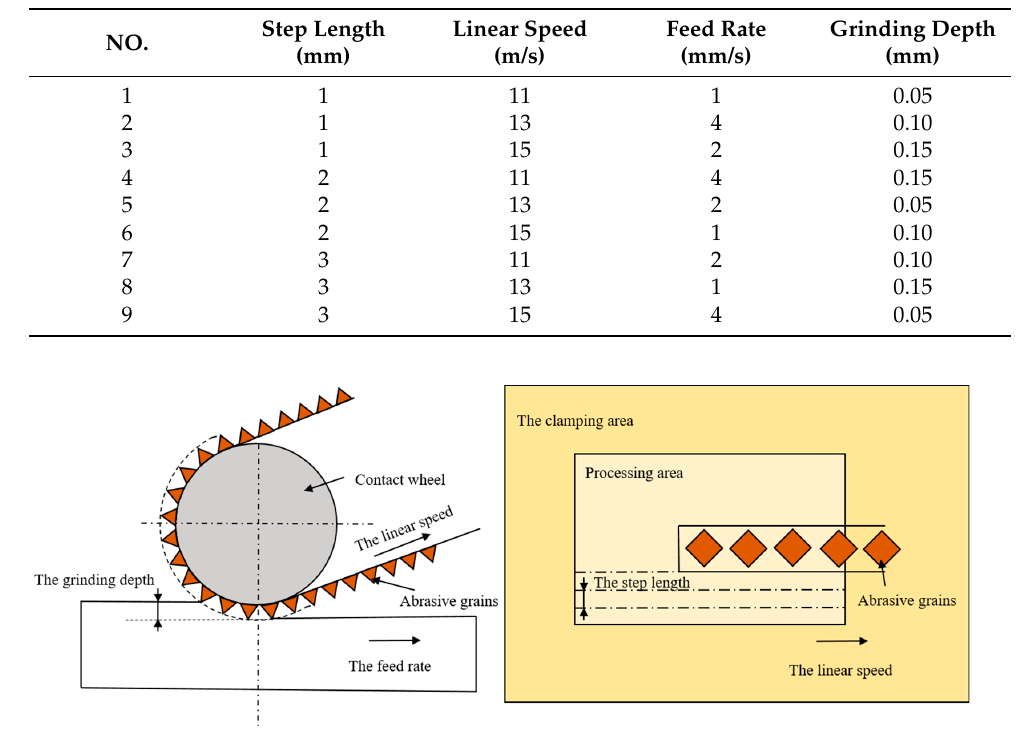
Figure 3. Grinding test abrasive belt sequence flow chart. 2.2.2. Surface Integrity Testing Surface roughness measurement was performed after each grinding session using a hand ‐ held roughness meter with a measurement length of 0.25 × 5 mm and a sampling length of 0.25 mm. 5–7 repeated measurements were performed each time, and the aver ‐ age of 3 reasonable data was taken as the final data to achieve high reliability of the test results. After each measurement, the grinding experiment continued until the end. After the grinding experiments, other parameters of the samples were started. First, the super depth ‐ of ‐ field measurements were performed using the VHX ‐ 1000C/VW ‐ 6000 super depth ‐ of ‐ field 3D microscope system designed and manufactured by KEYEN. The basic surface morphology can be obtained by taking pictures of the titanium alloy surface with 300–500 times magnification. Three places were selected for each sample number to be photographed. Since the burned part of the titanium alloy plate could not be accurately measured in the residual stress test, a judgment on the surface burn of the titanium alloy could be made in ultra ‐ deep field photography. Next, a white light interferometer was used to scan the 3D profile to facilitate an in ‐ depth understanding of the entire surface morphology. First, the special scanning lens was replaced with a magnification of 500×, and then a flat scanning position was found. For each sample number, three flat locations were selected for scanning, allowing a 3D view of the ground surface texture and the grooves created by grinding. Residual stresses were measured using a Proto XRD device, which required 15 min of warm ‐ up to turn on. The equipment uses a Cu target with an inclination angle of − 30 °C to 30 °C for the measurement and was irradiated 11 times. The